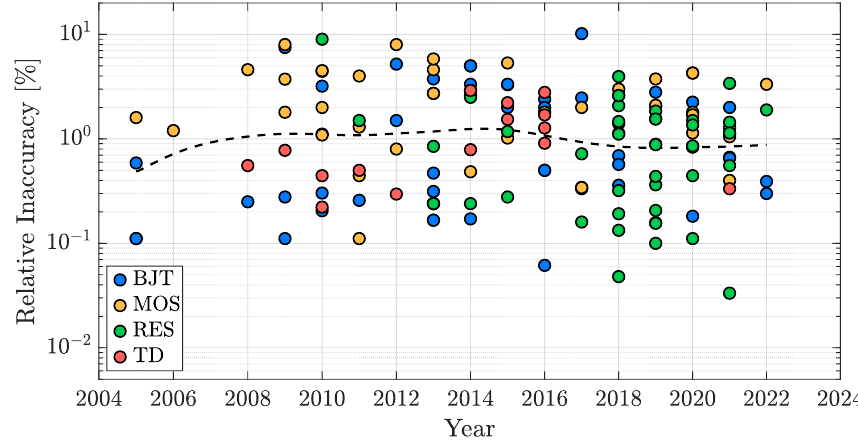
Figure 12. TDC inaccuracy time evolution in the last two decades.